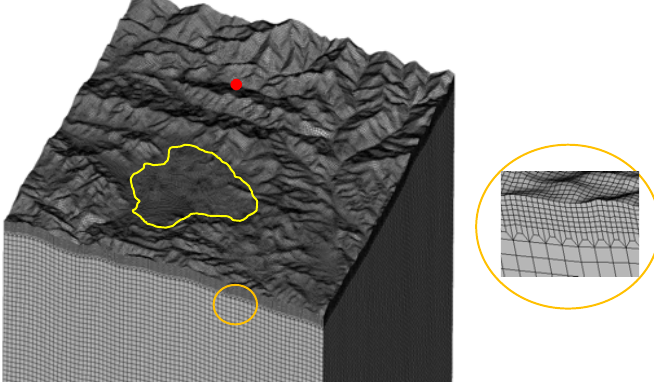
Figure 2. Spectral Element Mesh. ( Left ) The mesh for Kathmandu valley and surrounding areas. ( Right ) The enlarged version of near-surface mesh showing the realistic surface topography and triplication layer that has been applied. For sizes of the total area, cells and resolution of topography, see details in text and Table